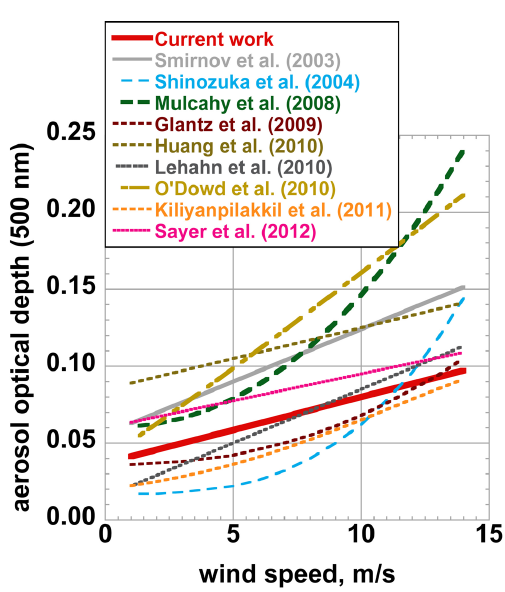
Fig. 6. Maritime aerosol optical depth as a function of wind